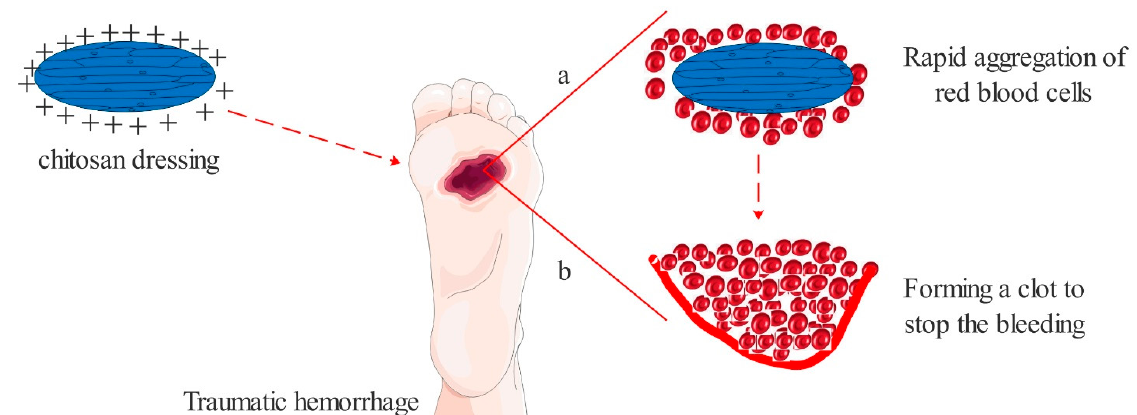
Figure 5. Hemostatic mechanism of chitosan. ( a ) Positive charge causes red blood cells to accumulate. ( b ) Material adheres to the wound.